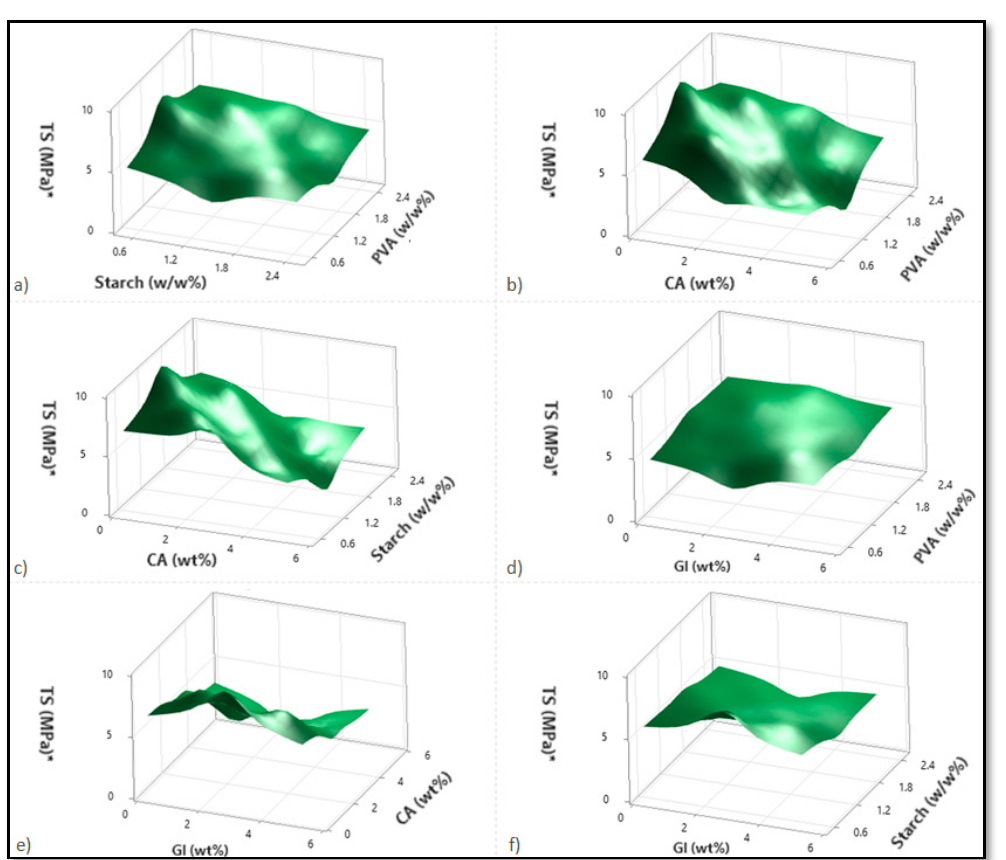
Figure 4. Corresponding response surface plots show the independent variables’ effects on tensile strength (TS (MPa)). ( a ) Starch-PVA, ( b ) Citric acid-PVA, ( c ) Citric acid-Starch, ( d ) Glycerol-PVA, ( e ) Glycerol-Citric acid, and ( f ) Glycerol-Starch.